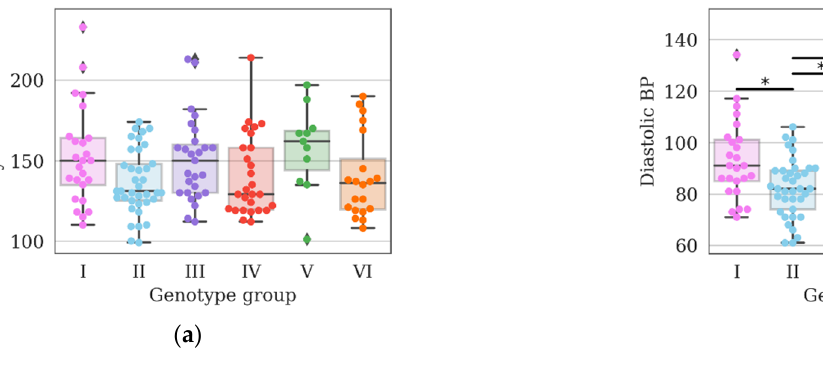
Figure 6. Differences in systolic ( a ) and diastolic ( b ) blood pressure (BP) among the obtained clusters; *—differences were considered significant at a corrected p -value ( p ) < 0.05 (Kruskal–Wallis test, post-hoc Dunn’s test 2-stage FDR